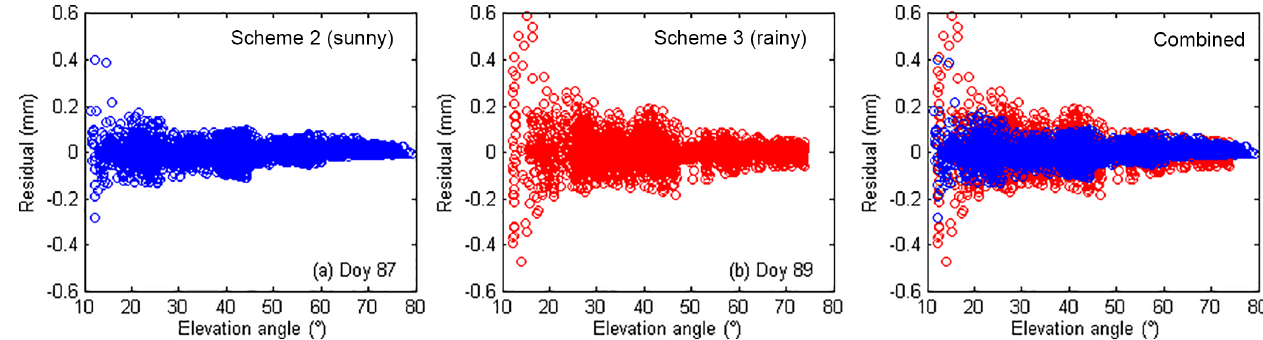
Figure 4. The change in SIWV residuals with cutoff elevation angle for Schemes 2 and 3.